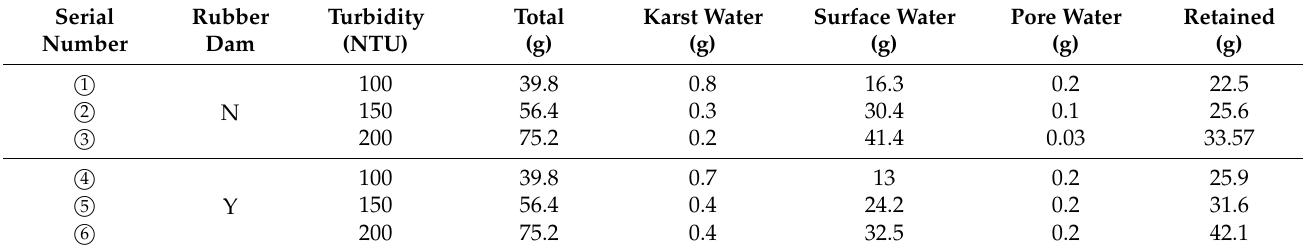
Table 5. Migration of suspended